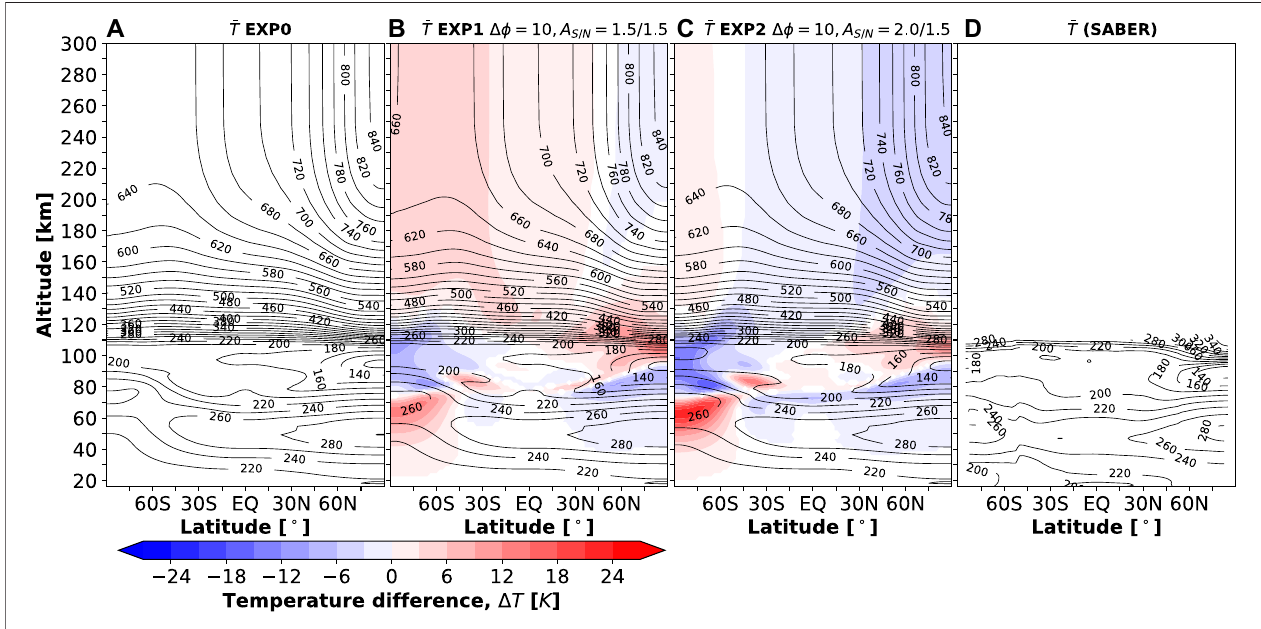
FIGURE 7 | Panels (A) – (C) are the same as in Figure 4 , but for the neutral temperature in K. Simulations are compared to the SABER temperatures in (D)